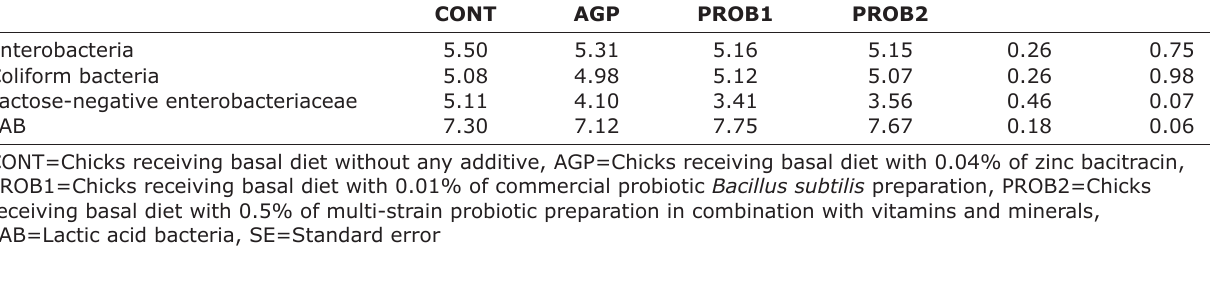
Table-8: Effect of multi-strain probiotic preparation in combination with vitamins and minerals on carcass traits of the Indonesian indigenous crossbred chickens. Items Dietary treatments